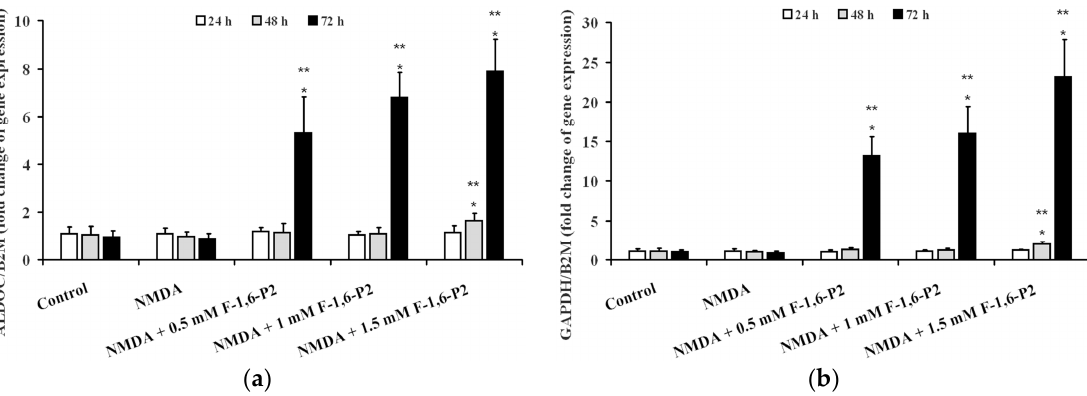
Figure 8. Effects of F-1,6-P2 on gene expression of aldolase (ALDOC) and glyceraldehyde-3-phosphate dehydrogenase (GAPDH) in NMDA-treated OHSC. OHSC were challenged with 30 μ M NMDA for 3 h and then incubated without and with increasing concentrations of F-1,6-P2 (0.5, 1 and 1.5 mM) for different times (24, 48 and 72 h). Control OHSC were incubated for the same time intervals, with no prior NMDA treatment or F-1,6-P2 addition. Semi-quantitative ALDOC ( a ) and GAPDH ( b ) expressions were determined in cell extracts, relatively to the housekeeping gene β -2-microglobulin (B2M). Histograms are the mean of 6 different OHSC preparations. Standard deviations are represented by vertical bars. * Significantly different from corresponding time of control OHSC, p < 0.001. ** Significantly different from corresponding time of NMDA-challenged OHSC with no F-1,6-P2 supplementation, p < 0.001.